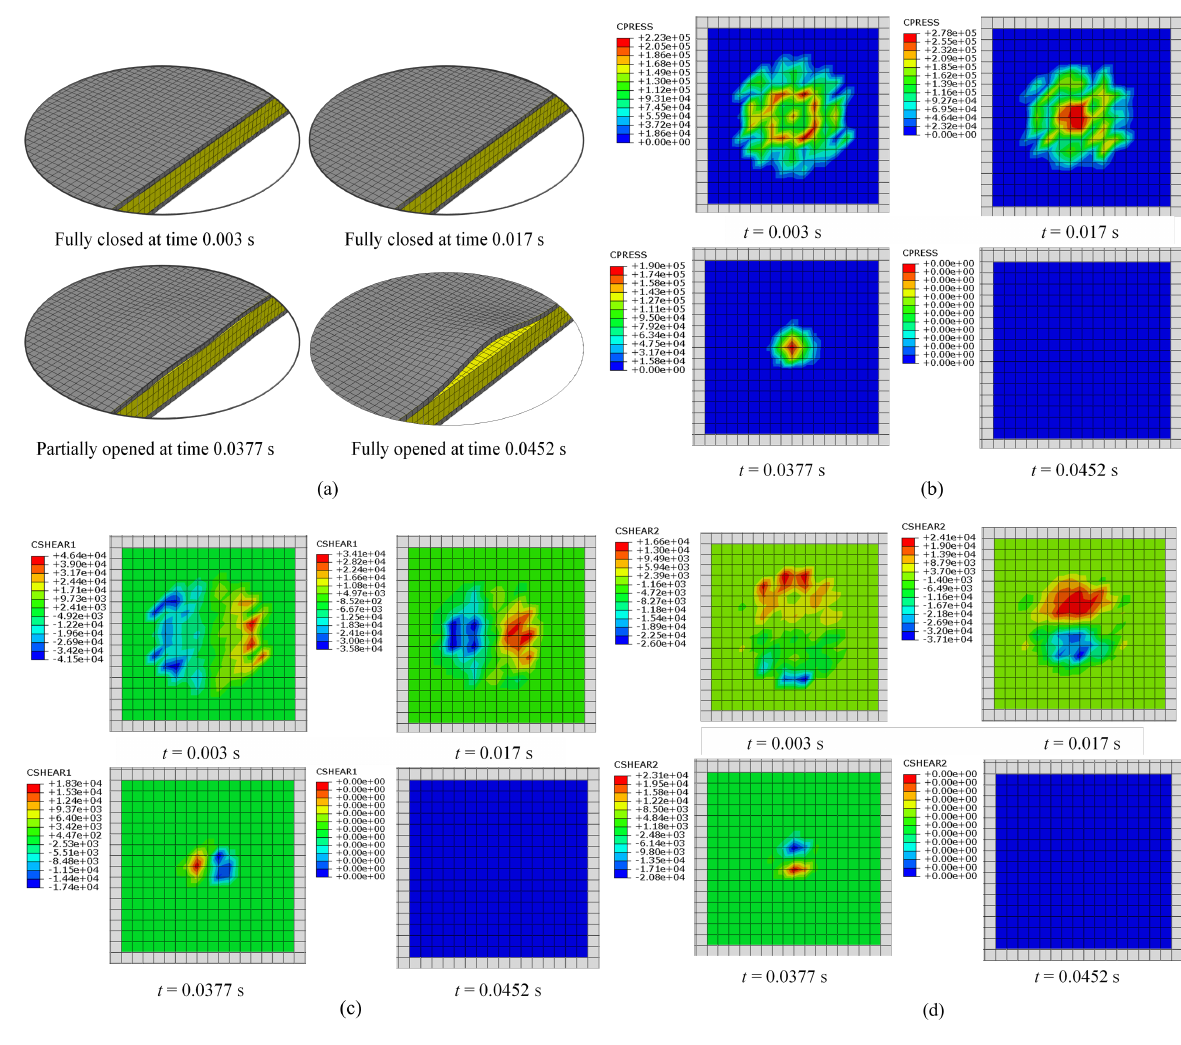
Figure 16: a) Deformed shapes of the debonded zone b) CPRESS c) CSHEAR1 d) CSHEAR2 at instants of time a) 0.0003 s, b) 0.017 s, c) 0.0377 s, d) 0.0452 s.